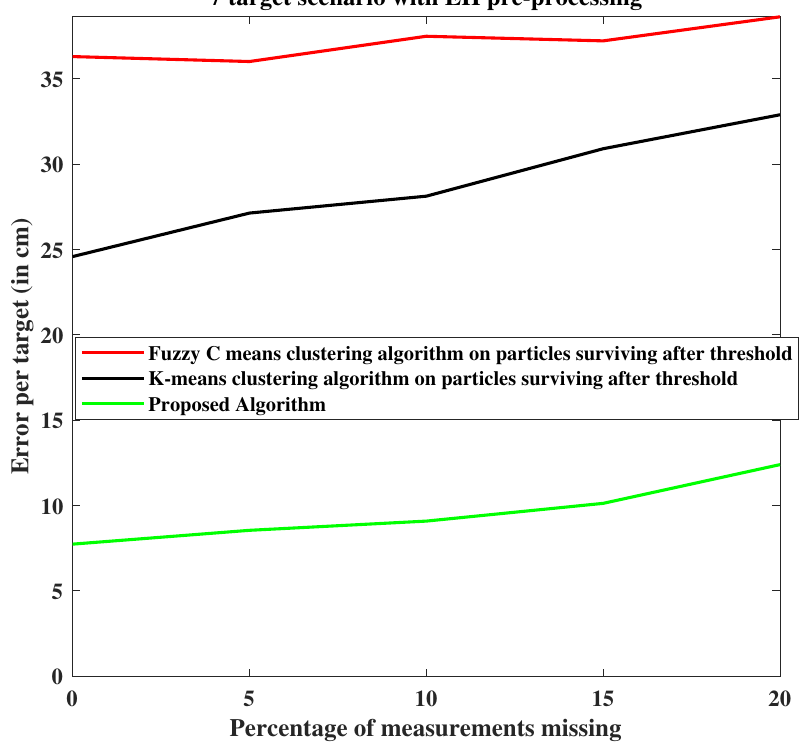
Figure 8. Performance comparison with missing measurements and for σ =